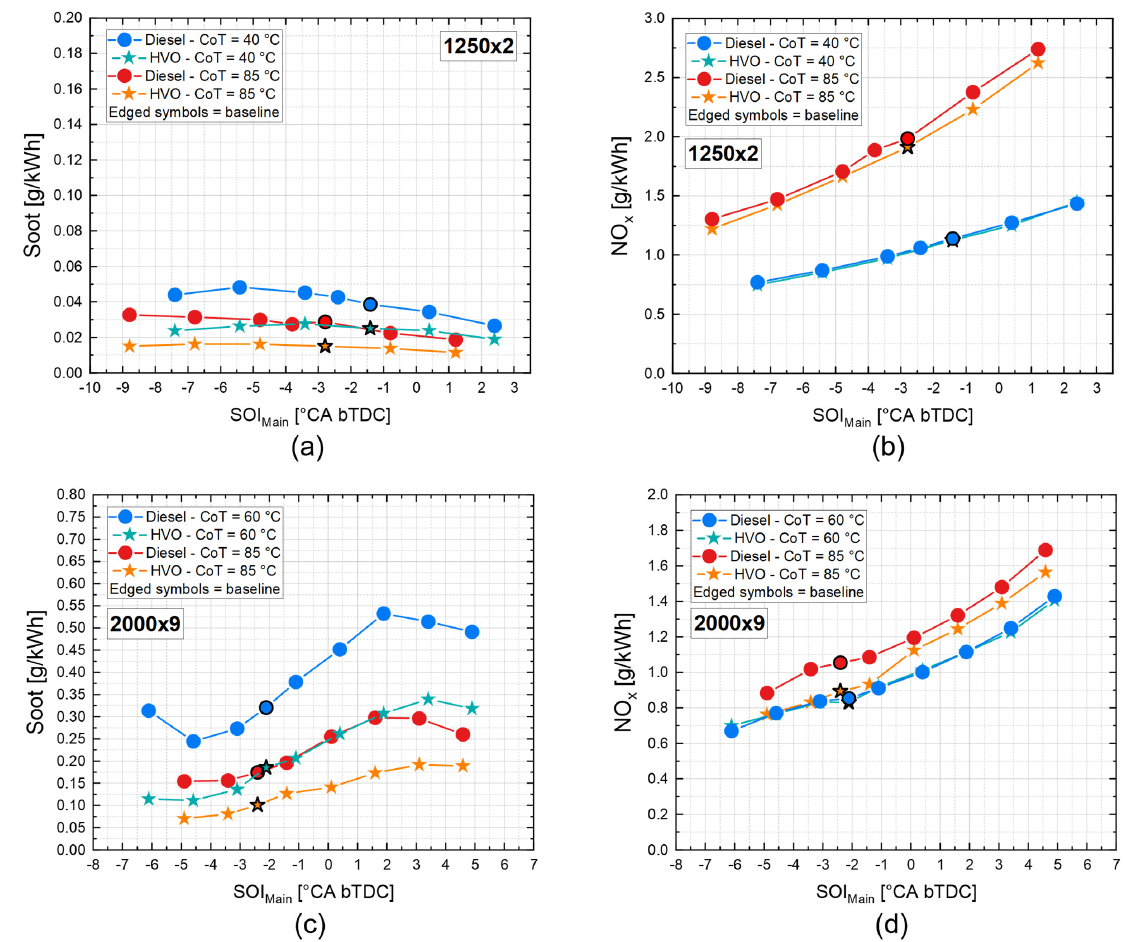
Figure 8. Soot and NO x emissions along SOI Main sweep tests at 1250 × 2 ( a , b ) and 2000 × 9 ( c , d ). Comparison between diesel and HVO at high and low coolant temperatures. Warm colors represent high coolant temperatures, while cool colors represent low coolant temperatures. Circles represent diesel, while stars represent HVO.